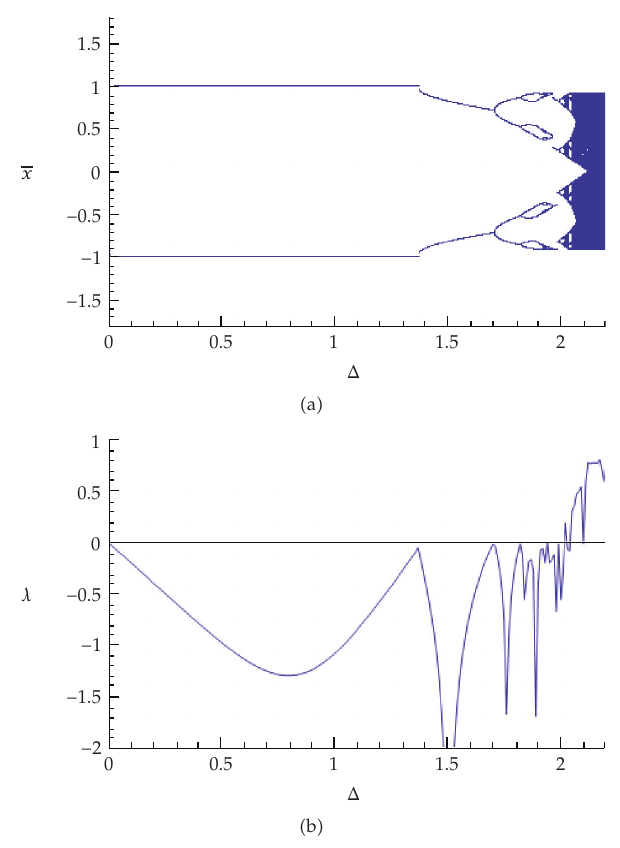
Figure 8: Bifurcation and Lyaponov exponent diagrams as a function of Δ